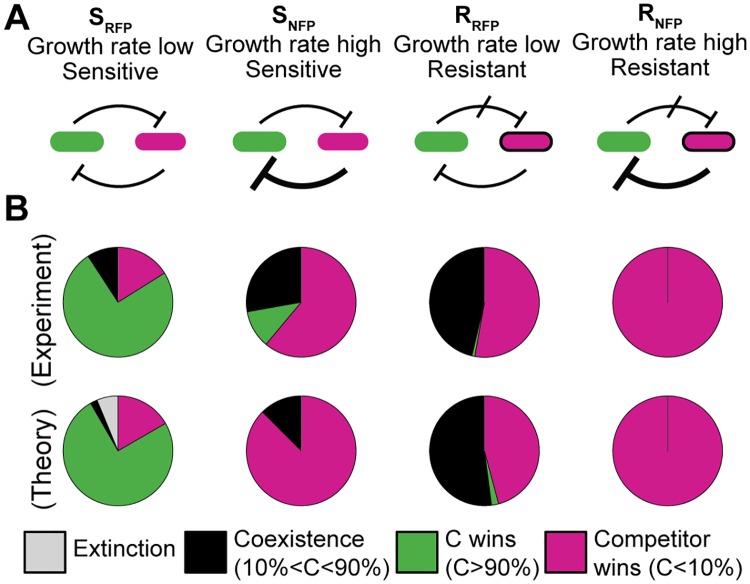
ColicinE2 producer strain (C strain) dominance depends on the competitor’s strategy.Experiments were performed at 0.005 μg/ml mitomycin C (MitC). Toxin resistance or induced growth enables the competitor to outcompete the C strain. Altering the background fluorescent marker expressed from fluorescent reporter plasmids in the respective strain, allows one to vary the growth rate of this strain. The expression of the red fluorescent protein (RFP) mCherry results in a significant growth rate reduction [3]. Strains indicated by no fluorescing protein (NFP) do not express a fluorescent protein. (A) Alternative competition strategies involving disablement of toxin action (RRFP, RNFP) and/or increased spatial exclusion (SNFP, RNFP) compared to the original toxin-sensitive strain (S strain) (SRFP). (B) Experimental (top) and simulated competitions (bottom) yield similar outcome distributions.